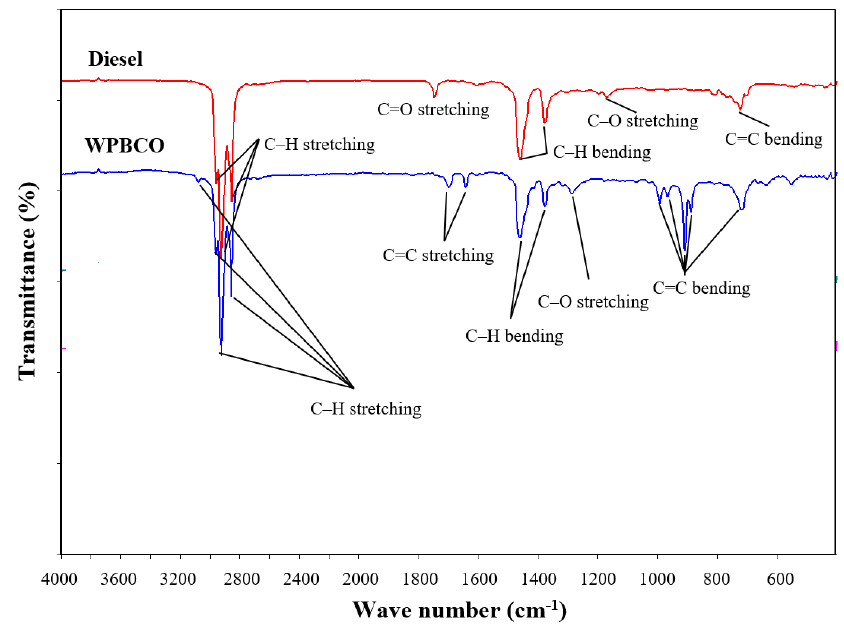
Figure 4. FT–IR spectrum analysis results for diesel fuel and WPBCO.